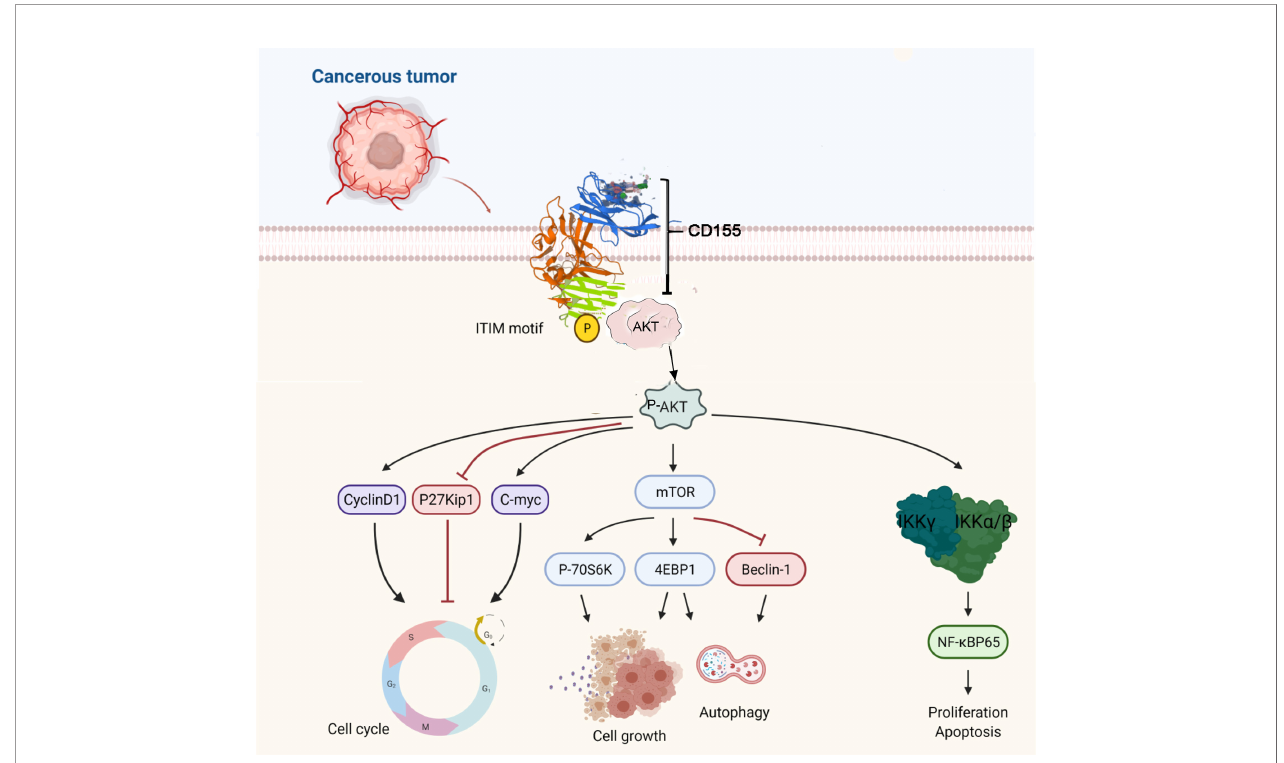
FIGURE 7 | The proposed mechanism of CD155 in cervical cancer